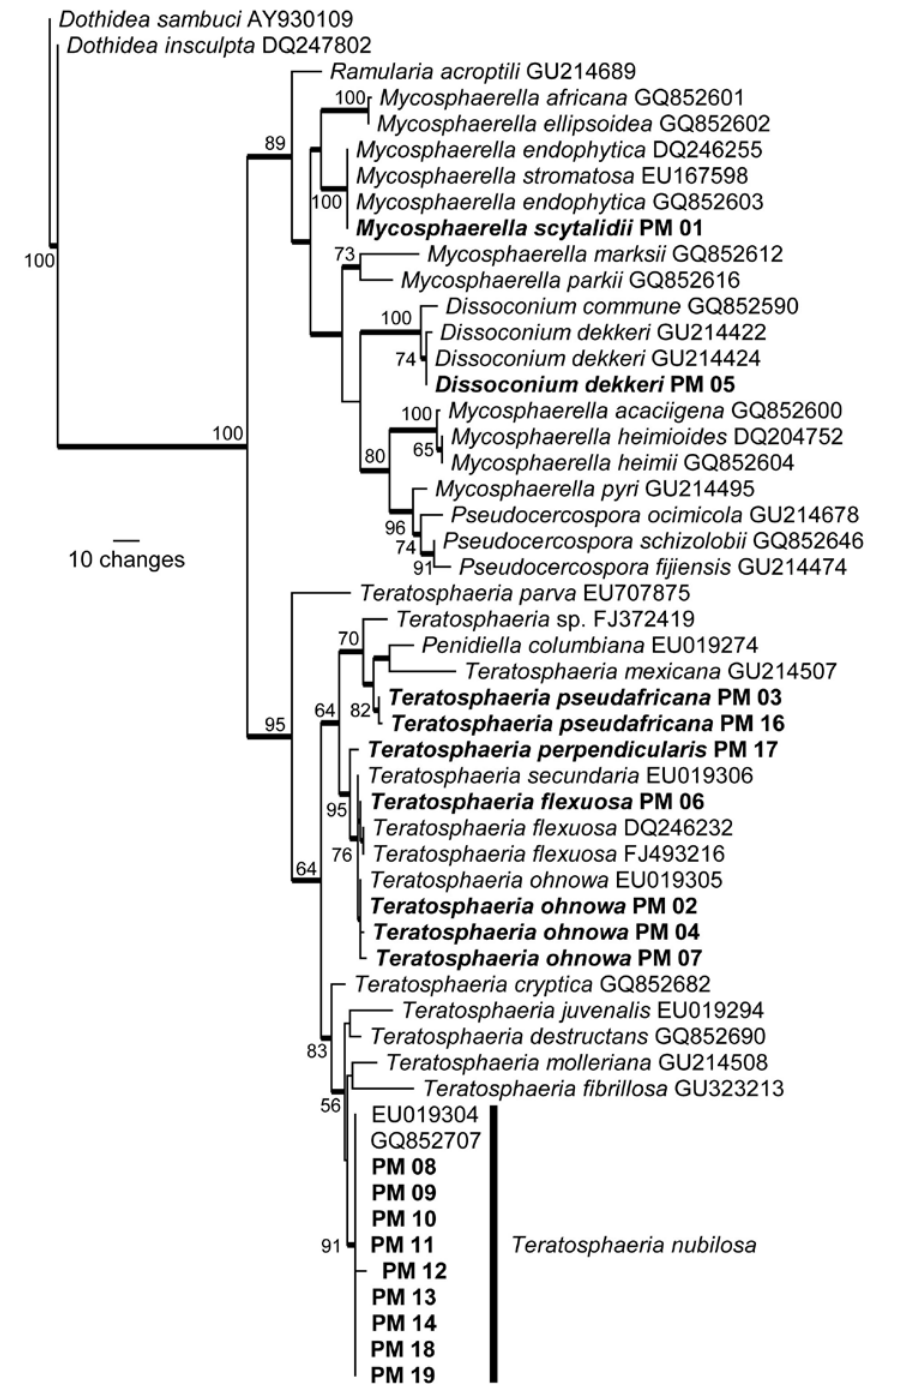
Figure 3. The first of 16 equally most parsimonious trees obtained from a heuristic search with 100 random taxon additions of the LSU sequence alignment. The scale bar shows ten changes, and bootstrap support values from 1000 replicates are shown at the nodes. The novel sequences generated for this study are shown in bold face and branches present in the strict consensus tree are thickened. The tree was rooted to sequences of two Dothidea